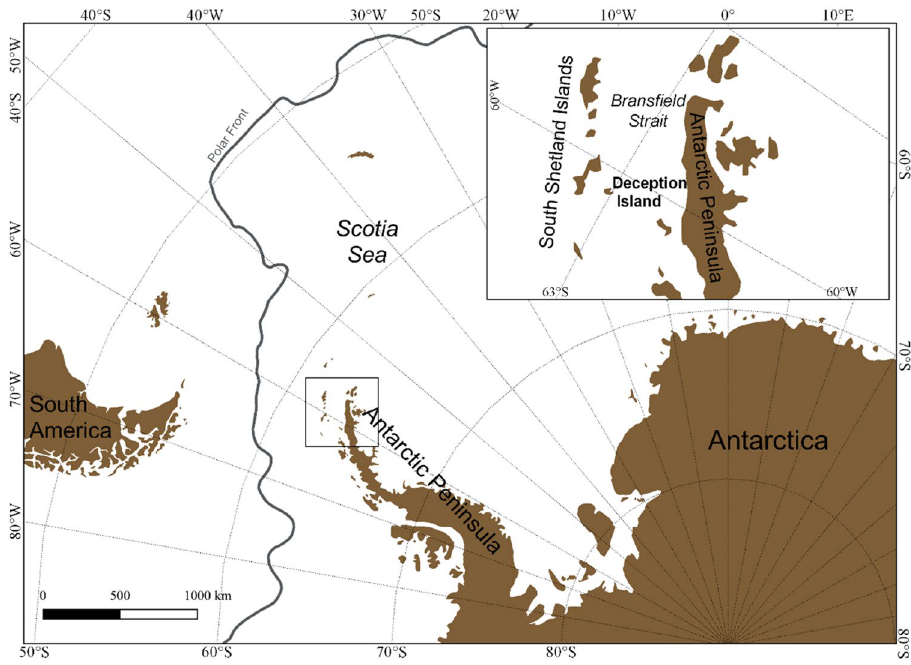
Figure 6. Map of the study area showing the Deception Island sampling location in the South Shetland Islands archipelago (Antarctic Peninsula). Map was created using the free software QGIS 3.10 (QGIS Development Team,